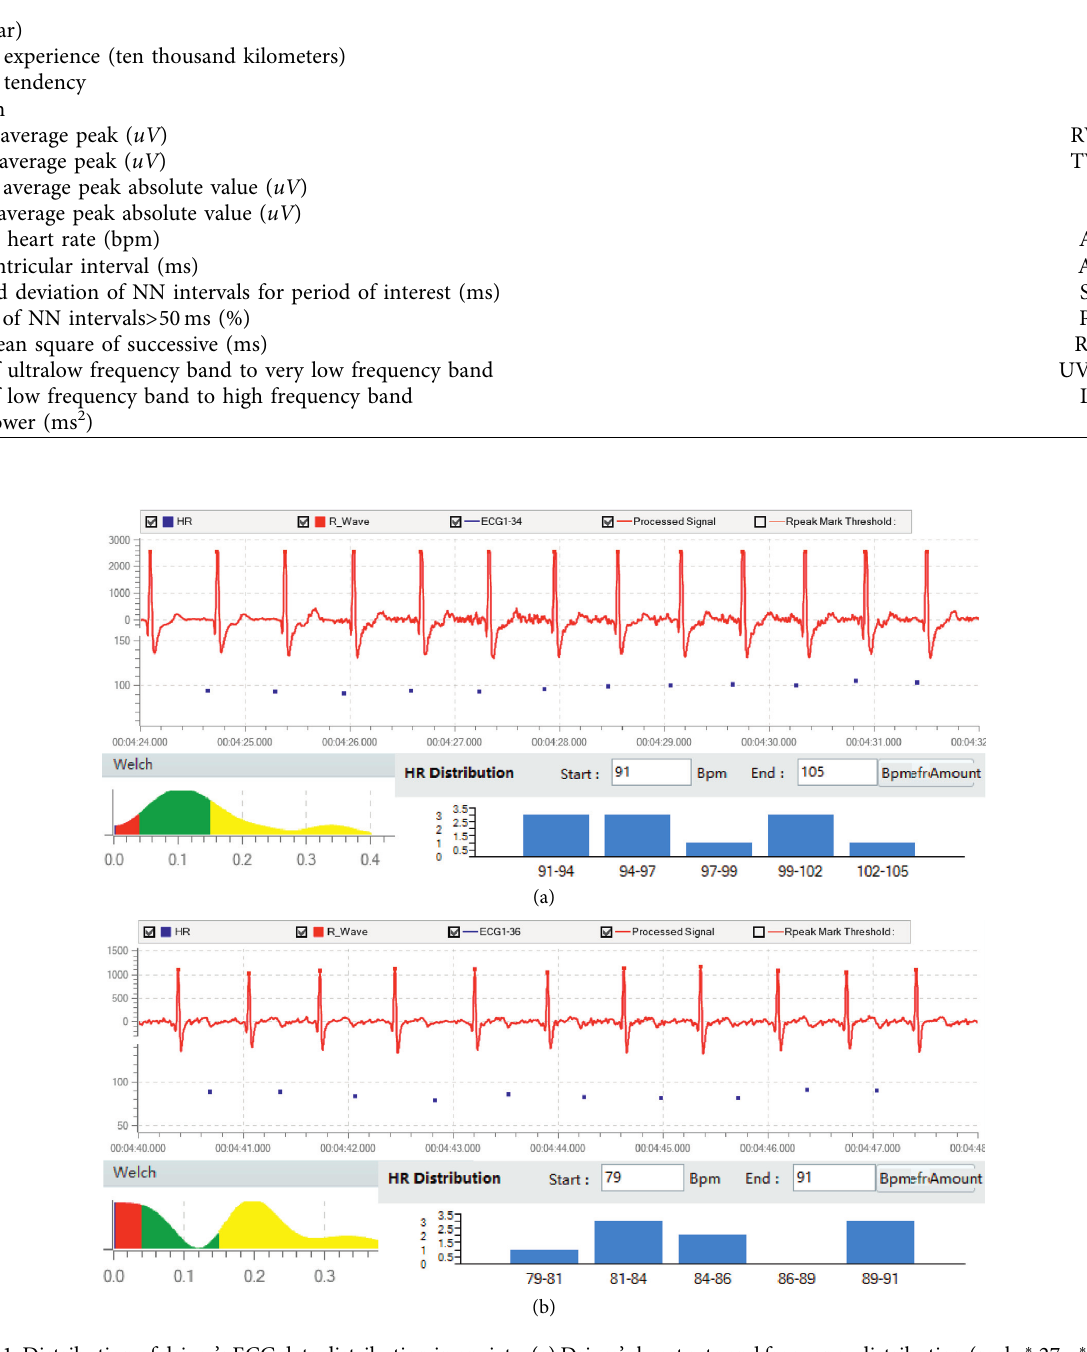
Figure 11: Distribution of driver’s ECG data distribution in anxiety. (a) Driver’s heart rate and frequency distribution (male ∗ 27y ∗ novice ∗ middle type). (b) Driver’s heart rate and frequency distribution (female ∗ 27y ∗ experienced ∗